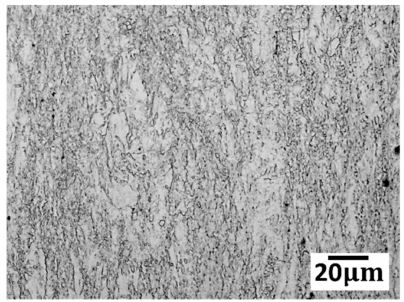
Figure 1. Microstructure of cold drawn Mg wire with a true strain of